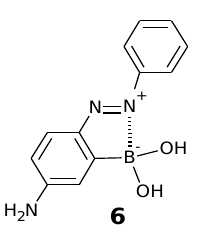
Figure 5. Chemical structure of dye 6